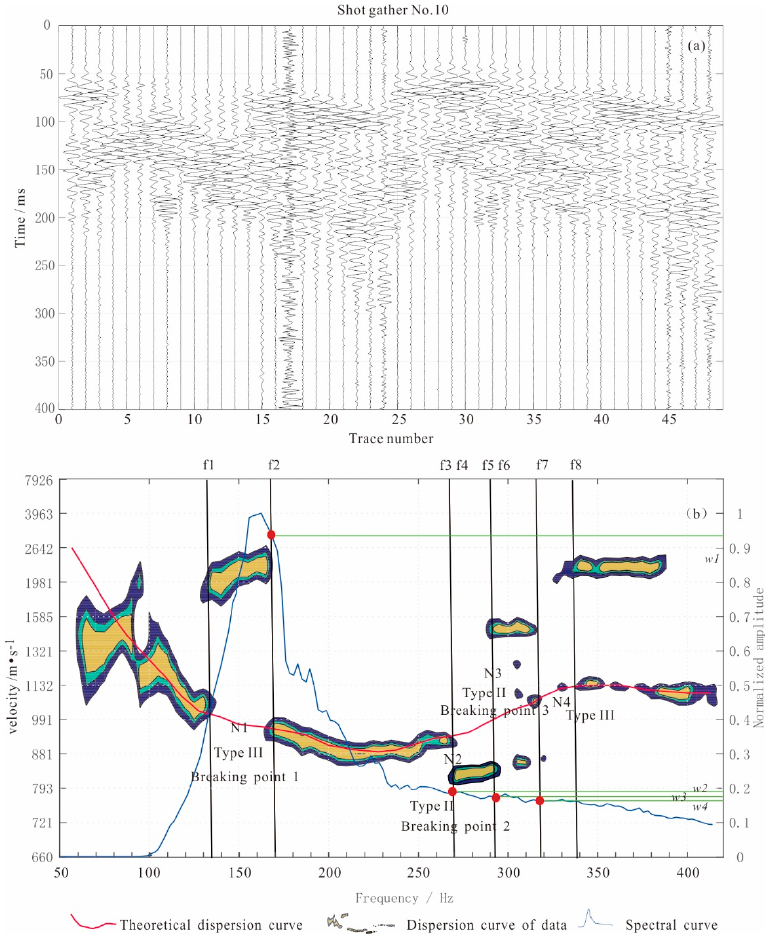
Figure 5. ( a ) Shot gather No.10; ( b ) Signal dispersion curve for the 10th source point of the 18th receiver point; the theoretical dispersion curve (red curve), and the spectral curve (blue curve). Airy phase frequency, 230 Hz; velocity, approximately 900 m/s. Table 1. Variability Parameters.